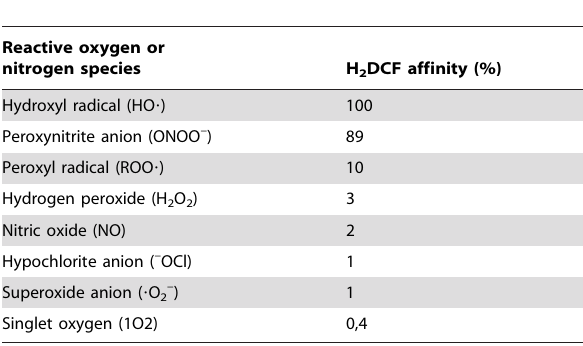
Table 1. Fluorescence response of H 2 DCFDA to various reactive oxygen and reactive nitrogen species [28].